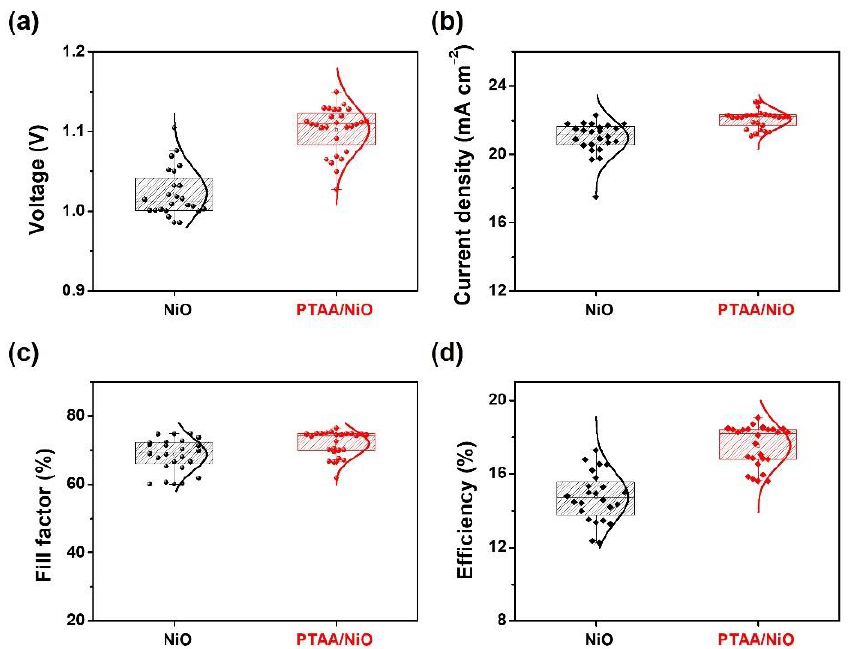
Figure 3. ( a ) J–V curves of the NiO and PTAA/NiO PSCs with active area of 1.12 cm 2 . ( b ) EQE spectra of NiO and PTAA/NiO based PSCs.